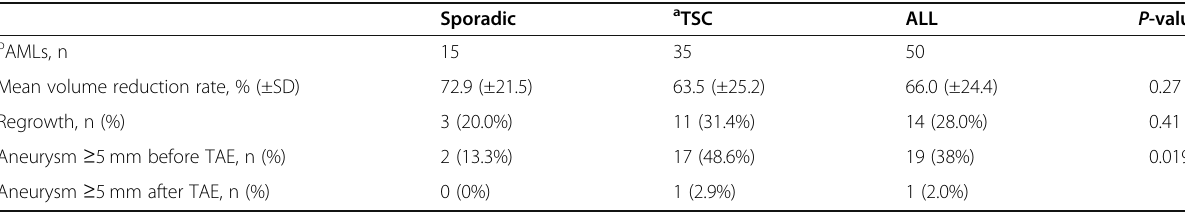
a TSC tuberous sclerosis, b AML